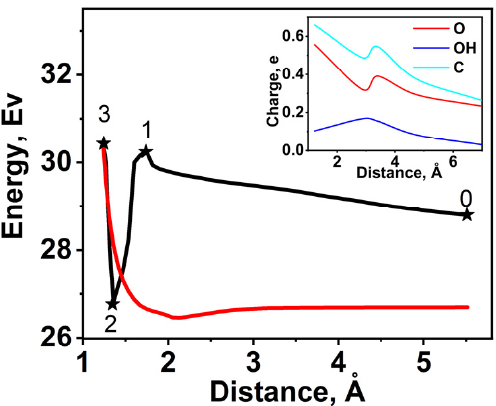
Figure 4. Repulsion energy of OOH group and tube surface E rep versus interatomic distance C=O with red curve for rigidly fixed C atom in surface layer, black curve for loose C atom, and inset for